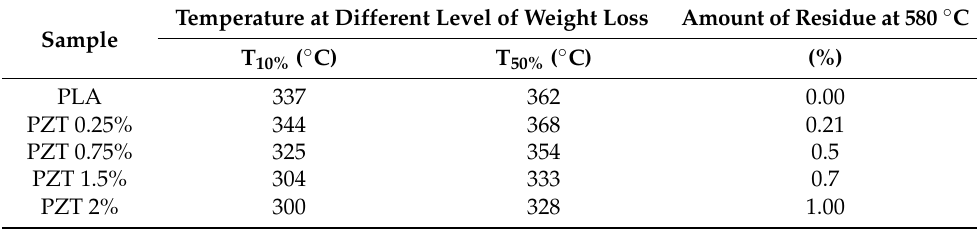
Figure 3. Thermogravimetric analysis of PLA and nanocomposites obtained. Table 2. Thermal properties of the samples obtained.